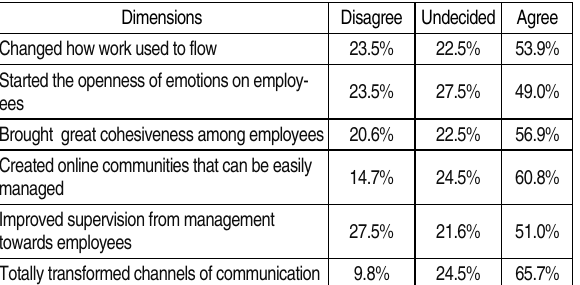
Table 2. Social media influence on